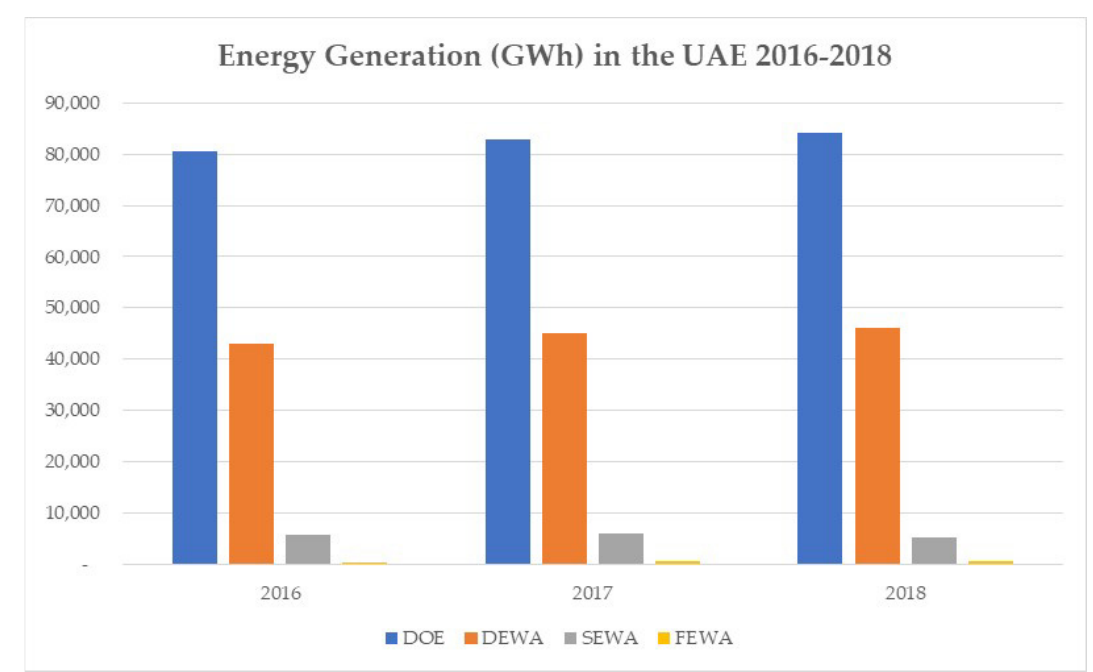
Figure 2. Energy generation in gigawatt hours (GWh) in the UAE between 2016 and 2018. Source: [8].